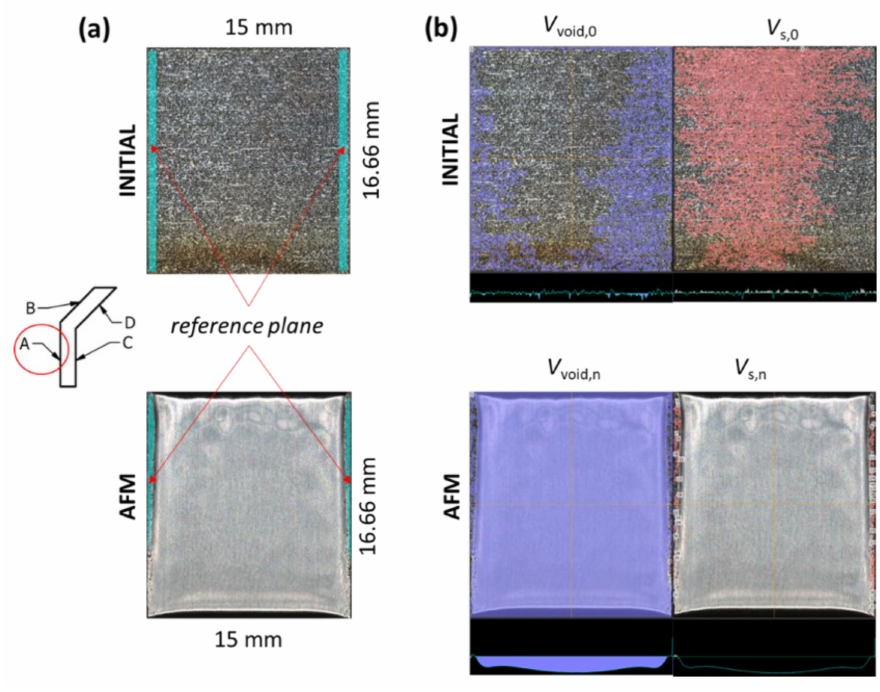
Figure 4. V-shape artifact, MR measurements: ( a ) Reference plane definition; ( b ) Void ( V void ) and solid ( V s ) volumes definition.